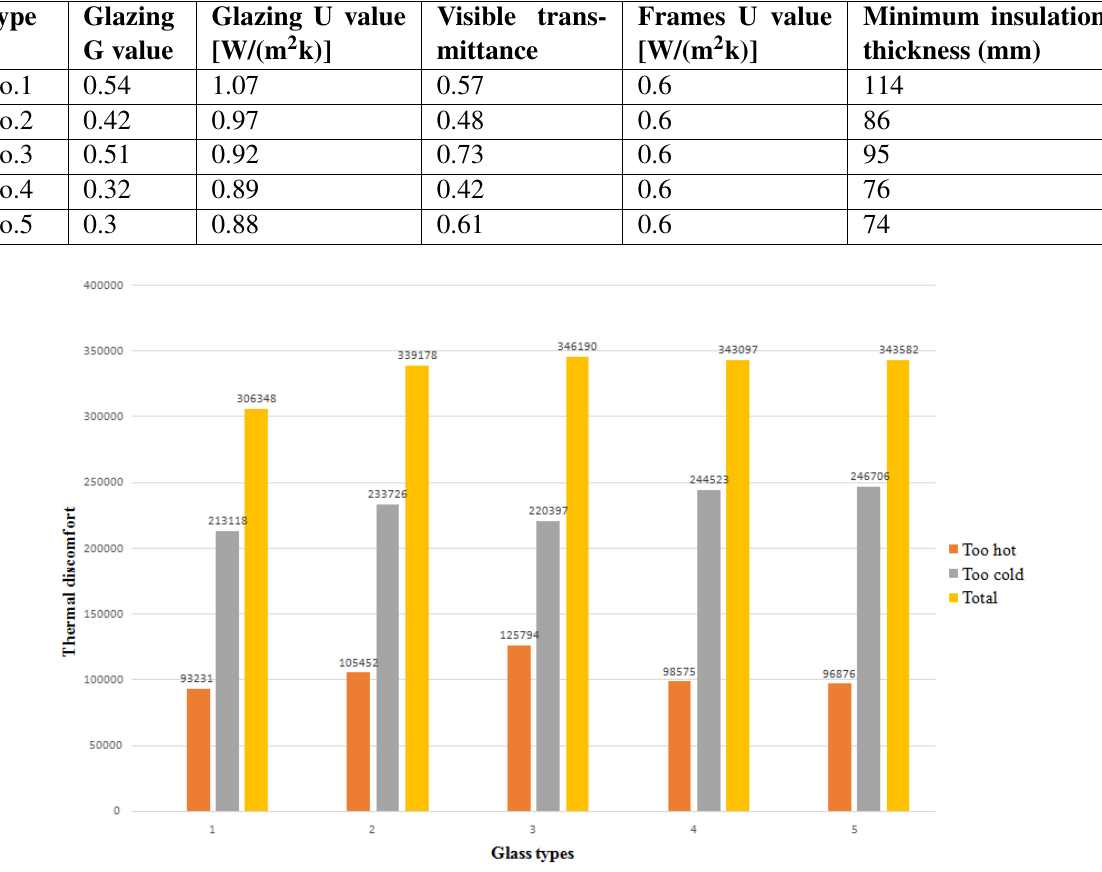
Fig. 8 Thermal discomfort of different glass materials.